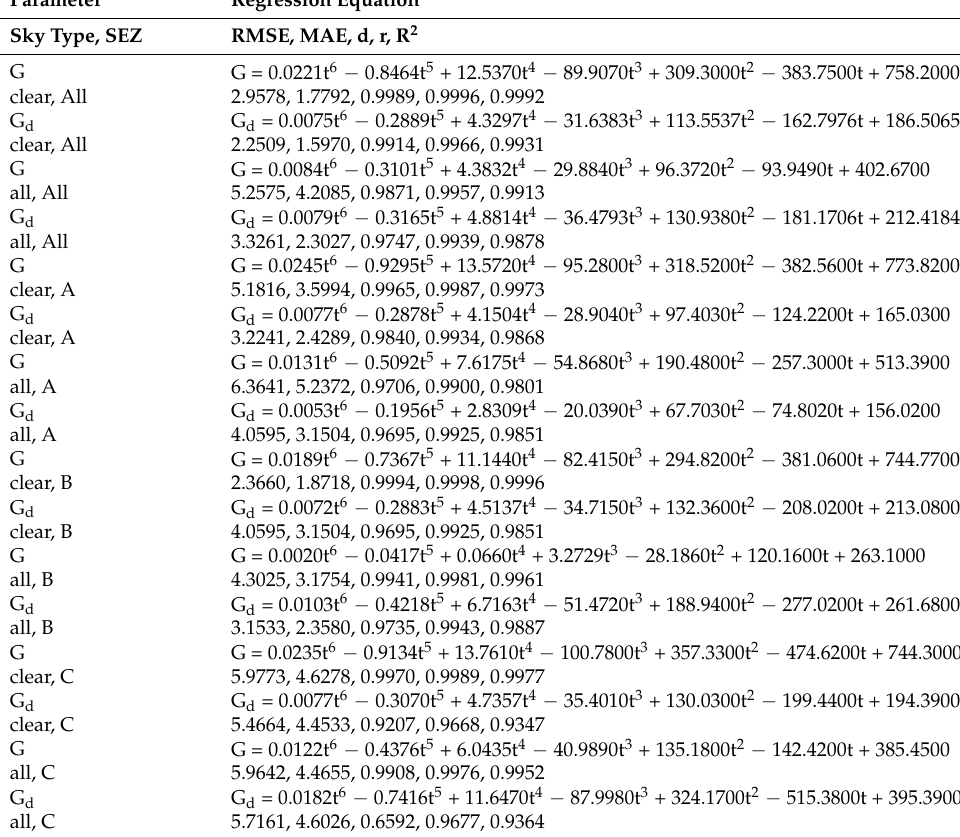
Table 2. Estimation of the monthly mean values of G (Wm − 2 ) and G d (Wm − 2 ), which are averages over the period 2013–2021, for all 43 sites in SEZ-All, or those sites that belong to the separate zones SEZ-A, SEZ-B, and SEZ-C. t is month (1 = January, 12 = December); statistical estimators for the model’s goodness-of-fit: RMSE (Wm − 2 ), MAE (Wm − 2 ), d, r, and R 2 . All statistical results were computed with the MICROSOFT’s Excel 2021